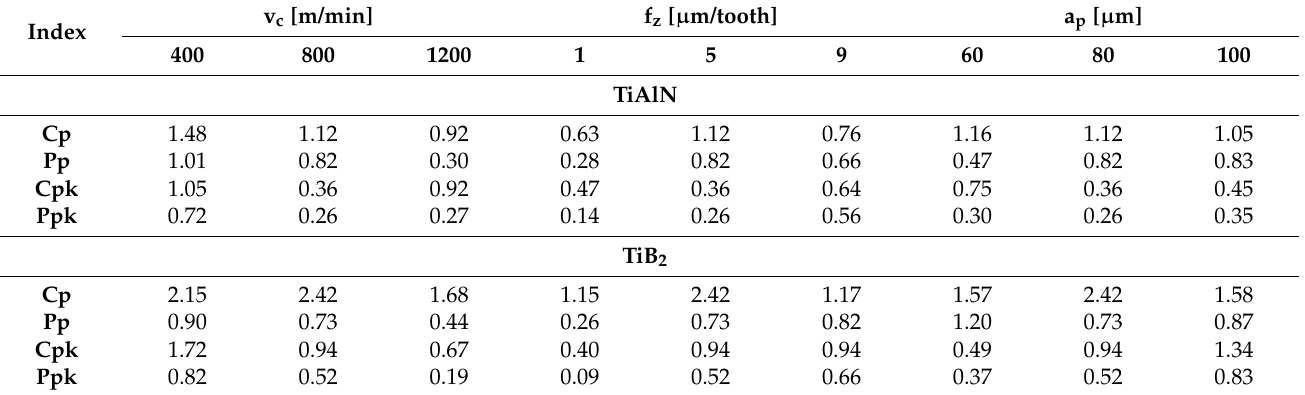
Table 4. Process capability indices versus variable technological parameters and tool coating type.